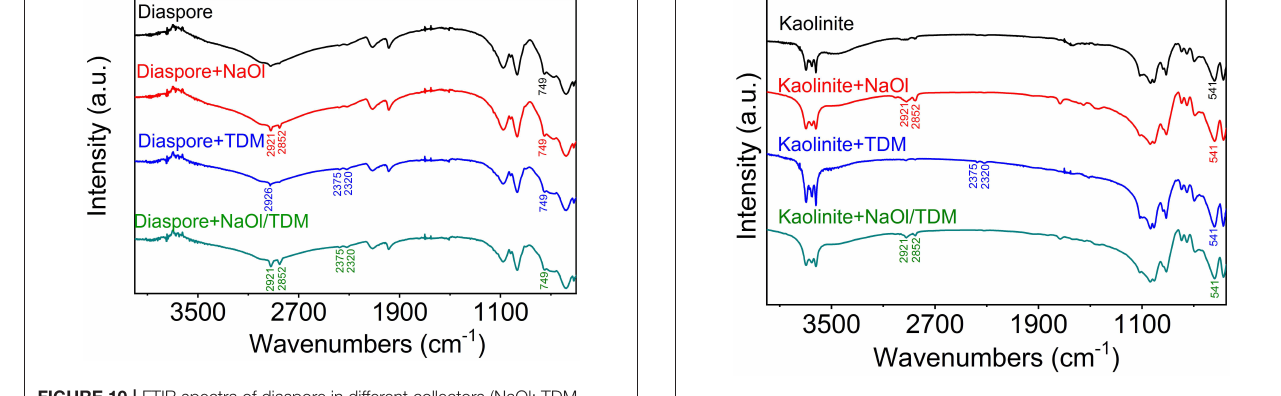
that TDM is physically adsorbed on the surface of